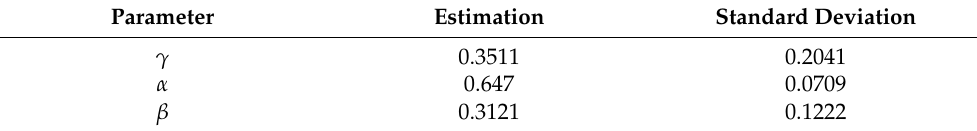
Table 4. Estimation